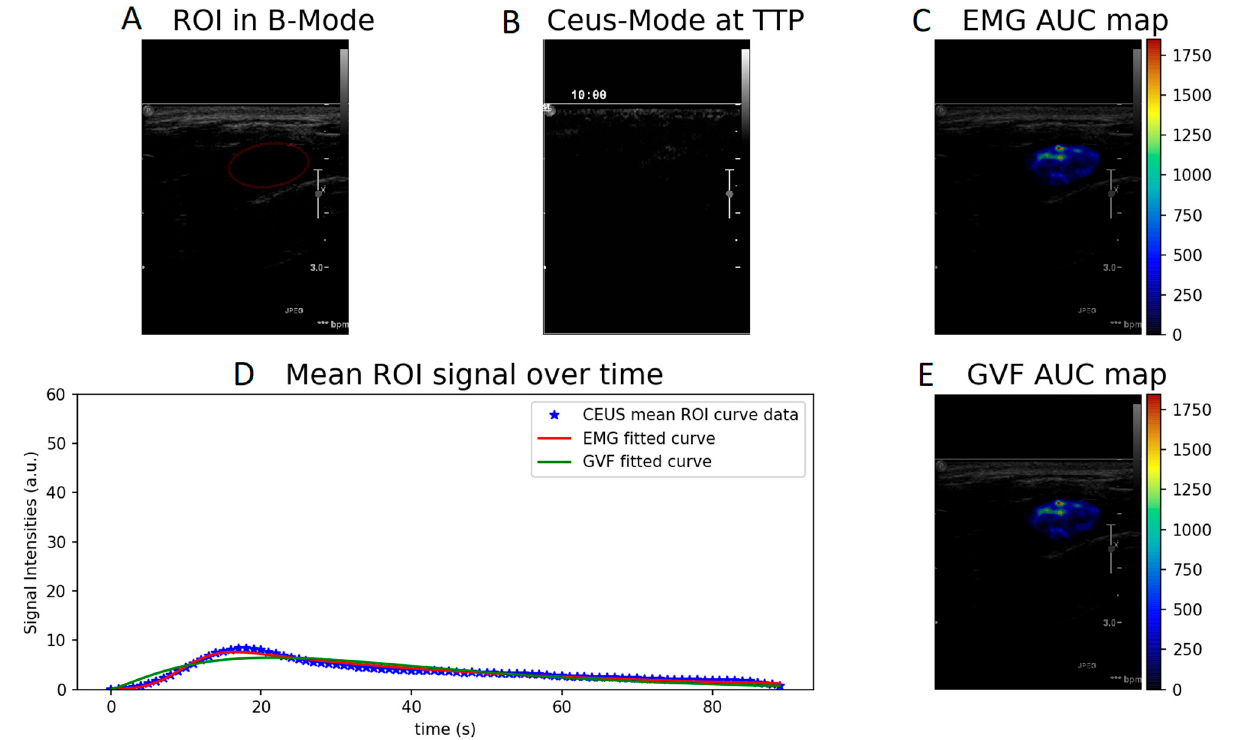
Figure 5. AUC parametric map calculated with EMG ( C ) and GVF ( E ) of a benign case. ( A ) ROI in B-mode, ( B ) CEUS mode at time to peak, and ( D ) EMG and GVF fitted to the mean ROI signal over